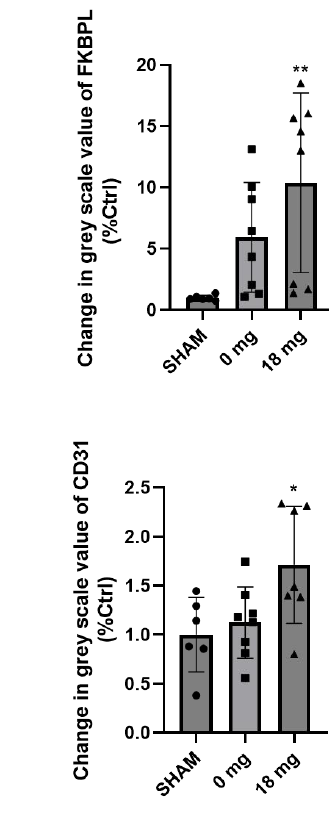
Figure 6. ( A ) Immunohistochemical on seven-week-old Balb/c female mice left ventricle sections (Scale bar = 20 µ m). Mice were treated in 3 groups: SHAM (ambient air), 0 mg (no nicotine), and 18 mg (nicotine) treatment groups. Sections were stained for FKBPL (green), CD31 (red), and DAPI (blue) and images were taken at 20 × . ( B ) FKBPL staining intensity was quantified as the mean greyscale value in three images per sample, ** p < 0.005 (SHAM vs. 18 mg). ( C ) CD31 staining intensity was quantified as the mean greyscale value in three images per sample, * p < 0.05 (SHAM vs. 18 mg). Results are expressed as mean ± SEM (n = 5–9) compared to SHAM. One-way ANOVA with Kruksal-Wallis post-tests was used for statistical analysis.